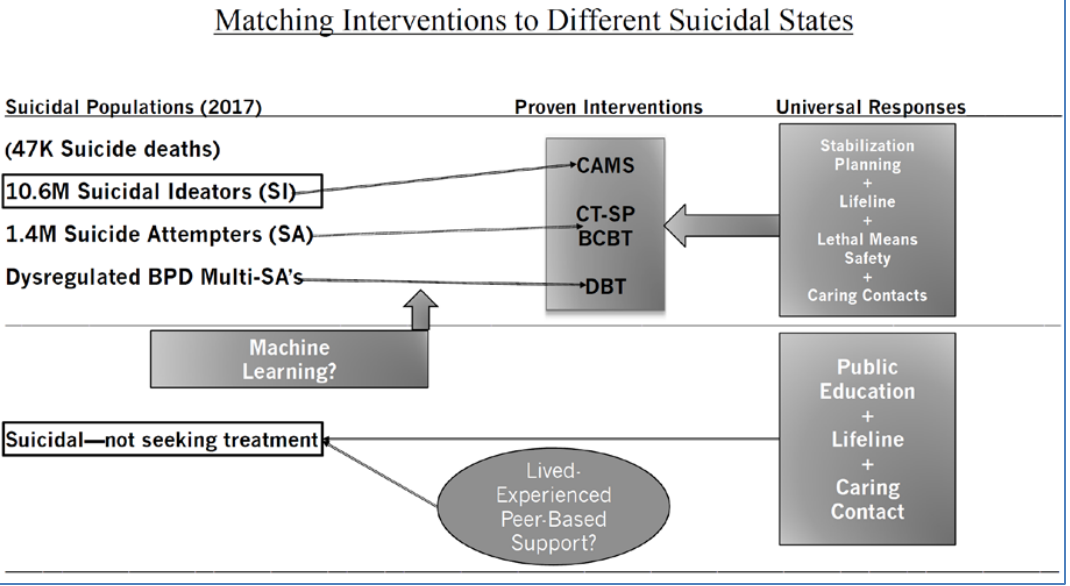
Figure 1. Different suicidal states include suicidal ideators (SI), suicide attempters (SAs), and multiple SAs. For those that seek mental health care: (SI) may be best matched to the Collaborative Assessment and Management of Suicidality (CAMS), SAs may be best matched to Cognitive Therapy for Suicide Prevention (CT-SP) or Brief Cognitive Behavior Therapy (BCBT), and dysregulated individuals with borderline personality disorder (BPD) with a multiple SA history may be best matched to Dialectical Behavior Therapy (DBT). Those that are suicidal but do not seek mental health treatment may be best matched to those with live-experienced and peer-based supports. Lifeline = the United States national suicide prevention lifeline phone number: 1-800-273-TALK (8255). From an even larger perspective, Figure 2 (adapted from an earlier figure that appears in [81]) depicts a “stepped care” model for suicide care. The healthcare costs, represented on the x-axis, are probably the single biggest force shaping healthcare practices in the real world. To this end, the top of the pyramid notes the most expensive systems-level interventions (i.e., inpatient psychiatric hospitalization) down to the least expensive interventions nearer the bottom of the pyramid.